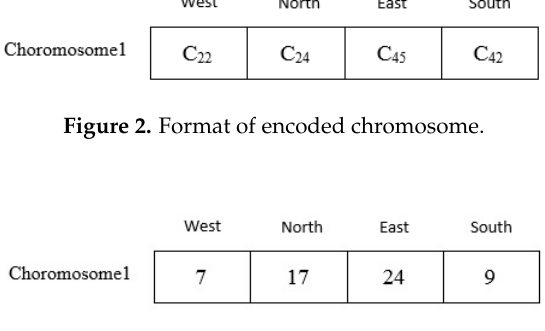
Figure 3. Example of encoded